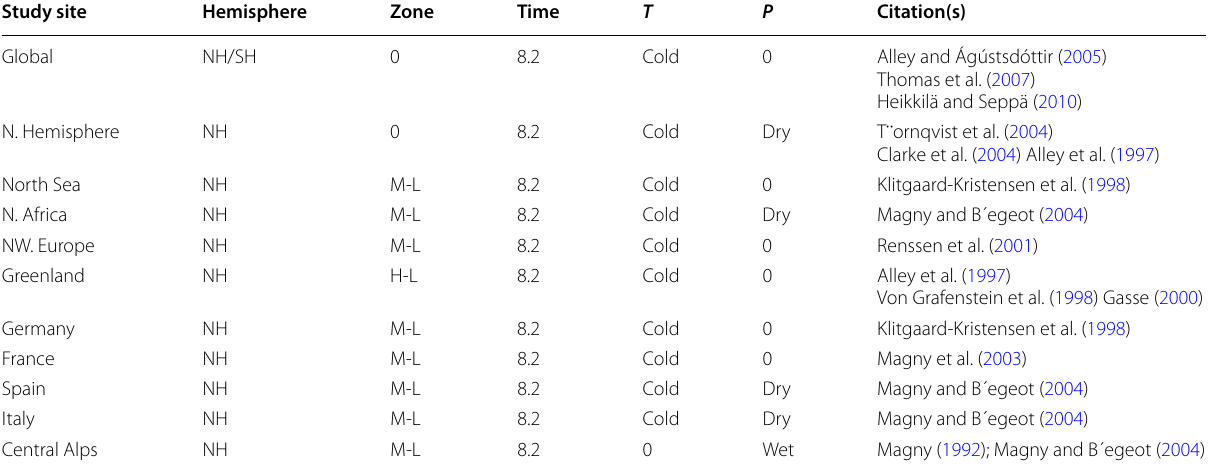
NH Northern Hemisphere, SH Southern Hemisphere, H-L High-latitudes, M-L Mid-latitudes. Period units are in ka